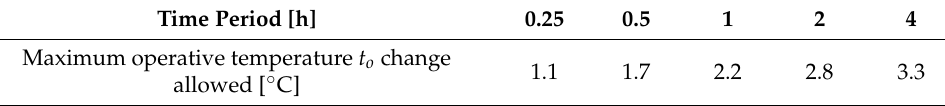
Table 2. Limits on temperature drift